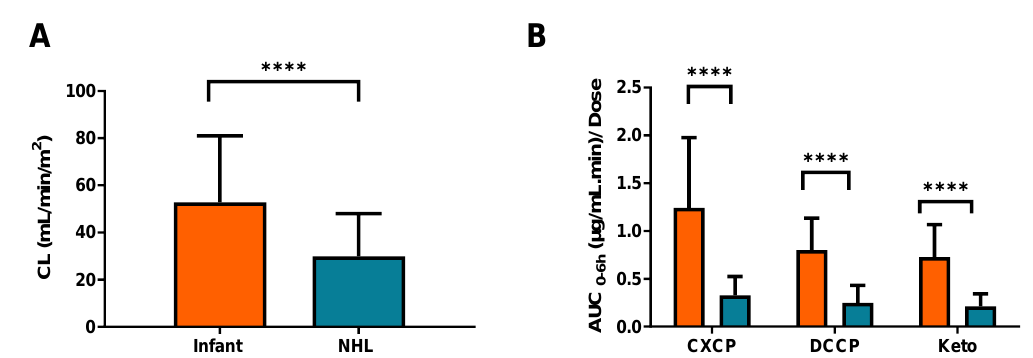
Figure 4. Observed differences between ( A ) cyclophosphamide clearance and ( B ) metabolite AUC 0–6h in patients from the current infant study (Orange) and a recently published study focusing on older patients with NHL (Blue). The error bars represent standard deviation, **** indicates a significance level of p < 0.0001.